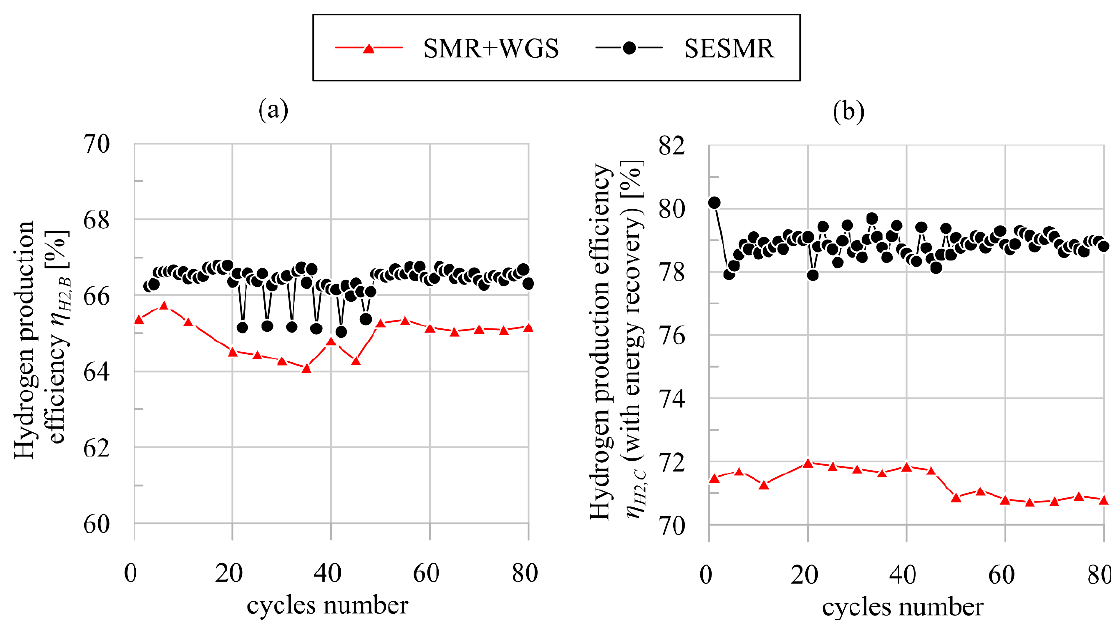
Figure 5. Hydrogen production efficiency ( a ) η H 2 ,B without thermal energy recovery and ( b ) η H 2, C with thermal energy recovery for SESMR and SMR.